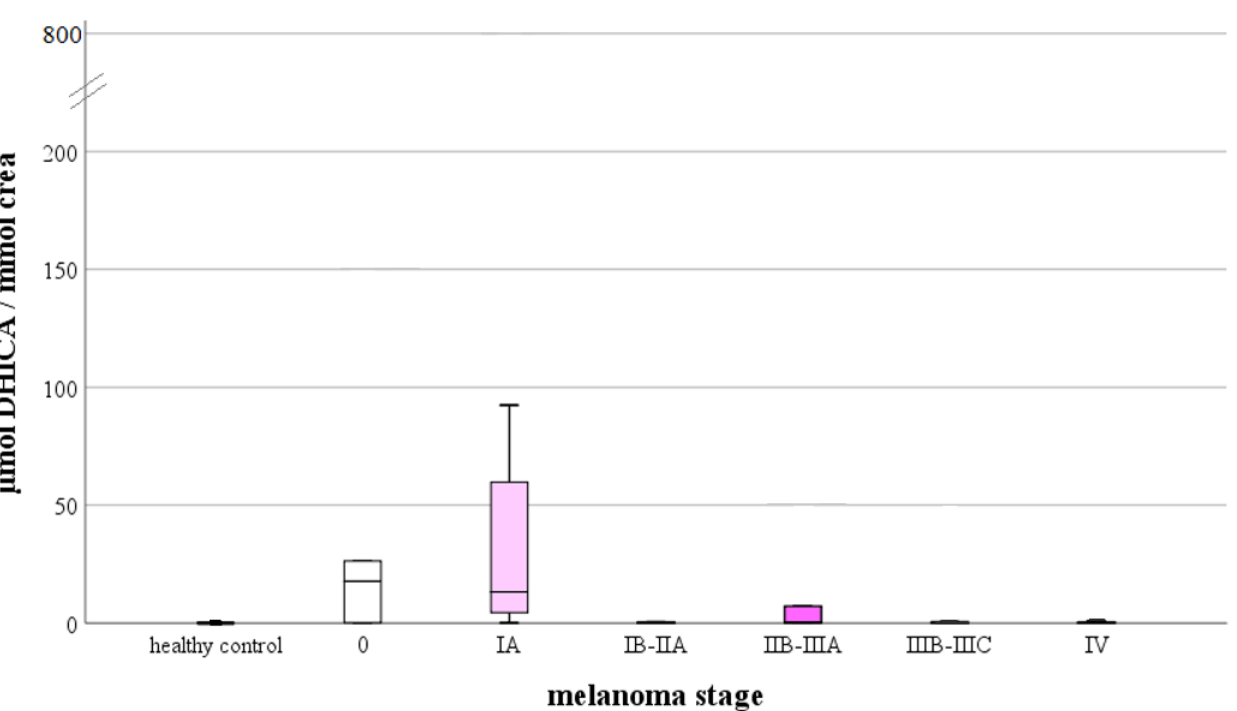
Figure 6. Comparison of 5,6-dihydroxyindole-2-carboxylic acid level relative to urinary creatinine concentration, based on the melanoma stages.